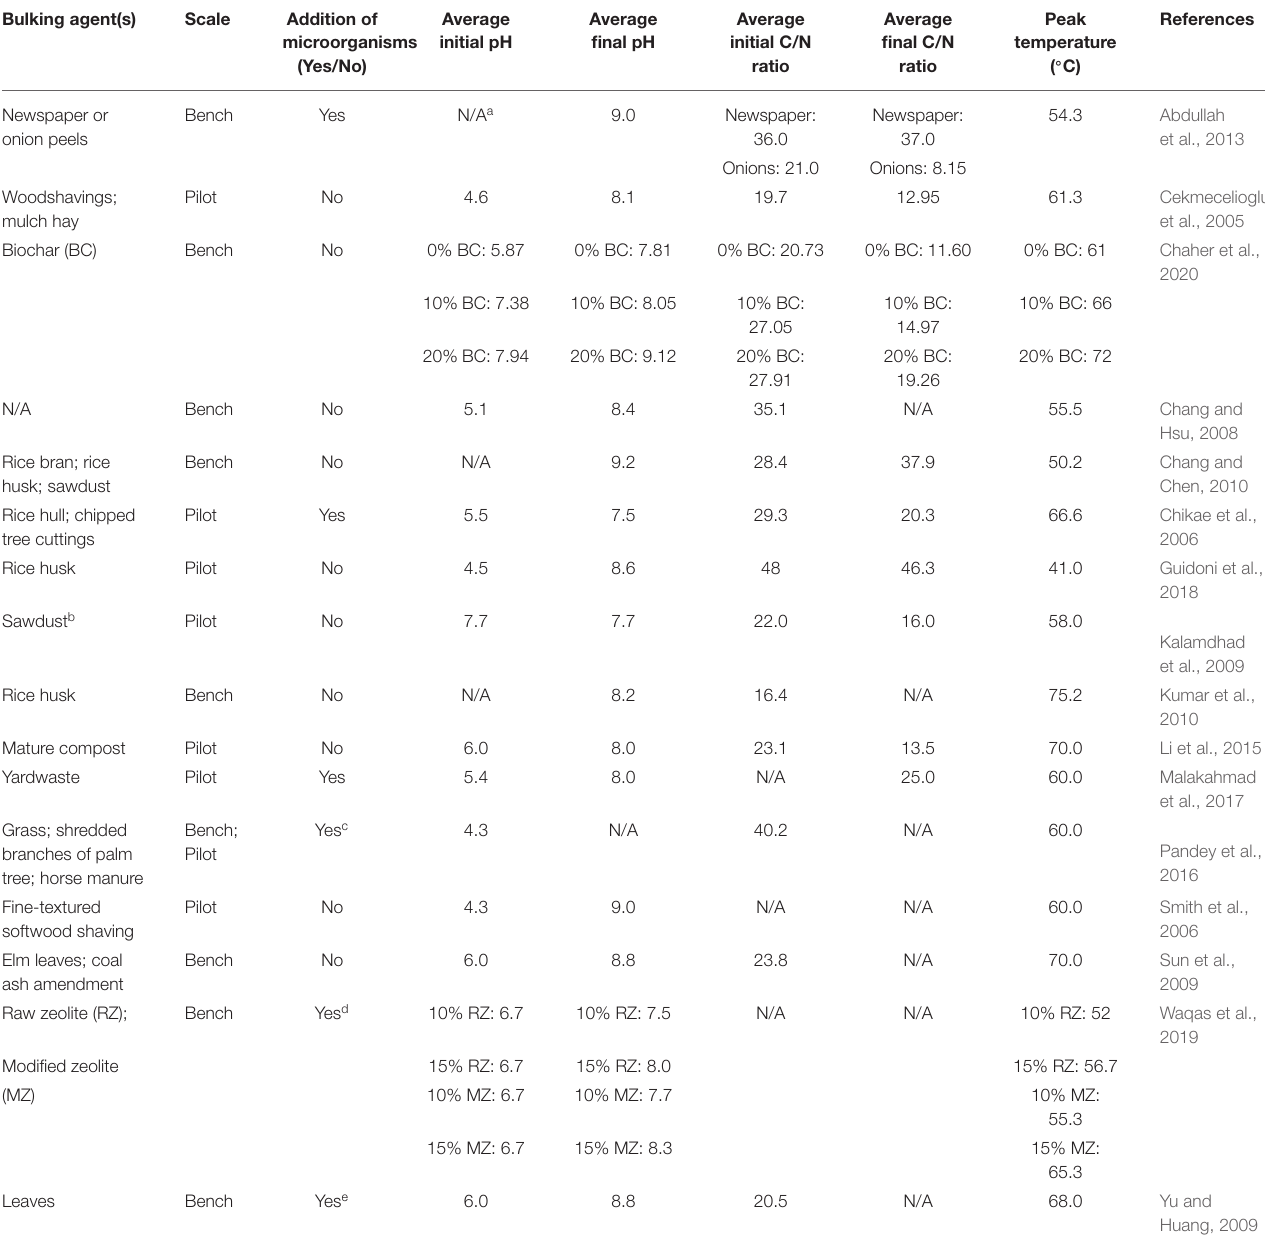
TABLE 5 | Variability in recorded research parameters from in-vessel composting of food waste feedstock. Bulking